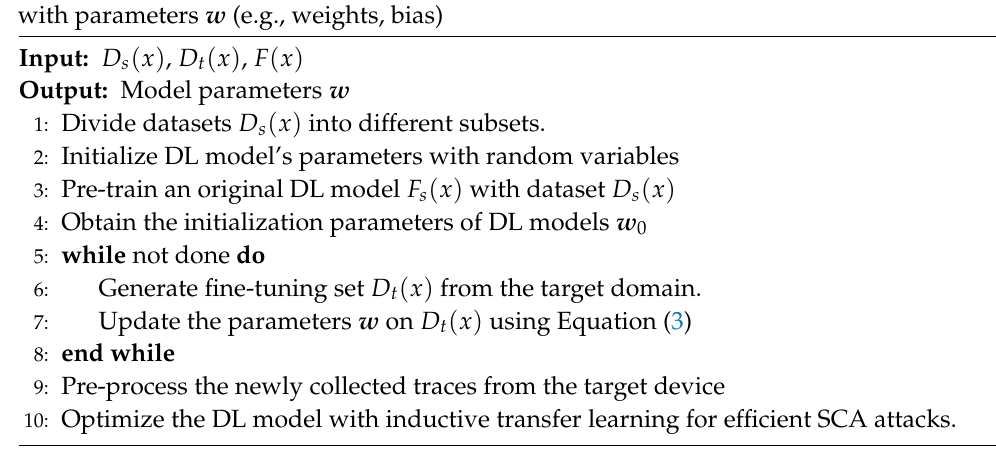
Algorithm 1 DCNNs Denoiser and SCA Attacks: For the datasets D s ( x ) and D t ( x ) from